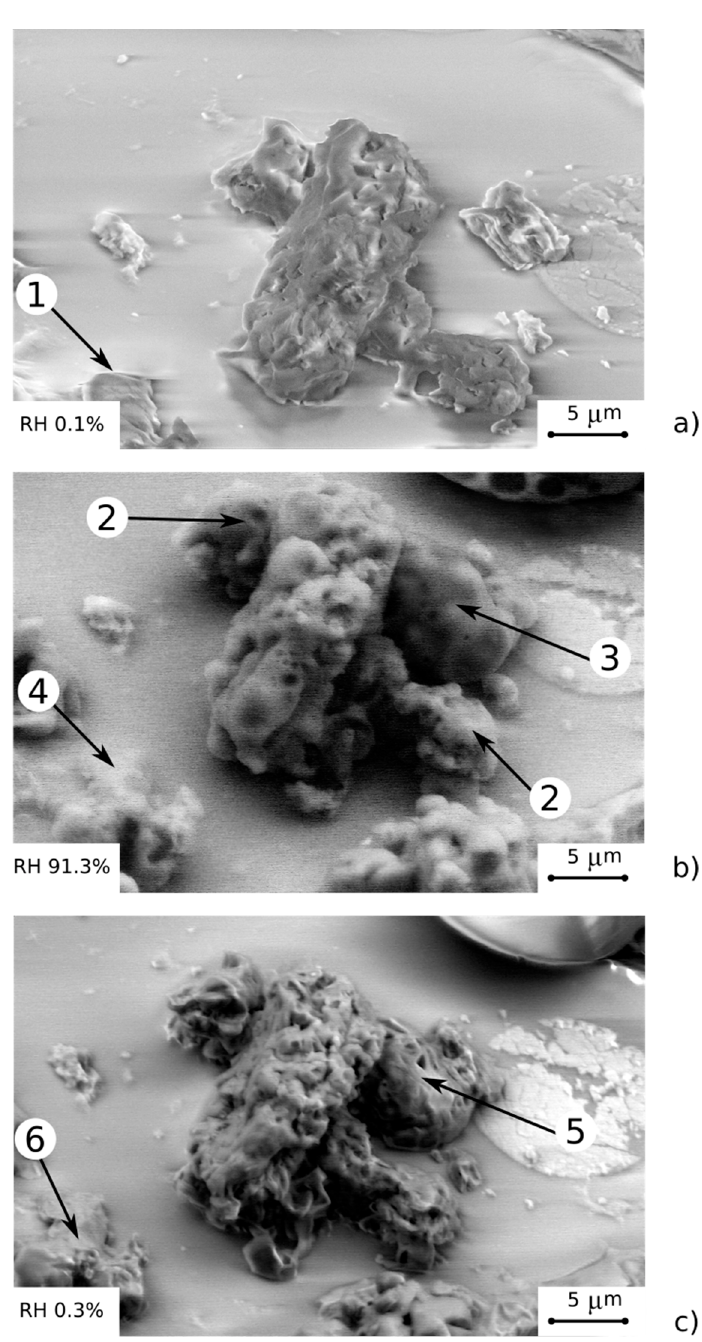
Figure 4. SEM images of salt hydrate composite foam: ( a ) P = 10 Pa and T = 40 °C, ( b ) P = 800 Pa and T = 5 °C, ( c ) P = 10 Pa and T = 25 °C.